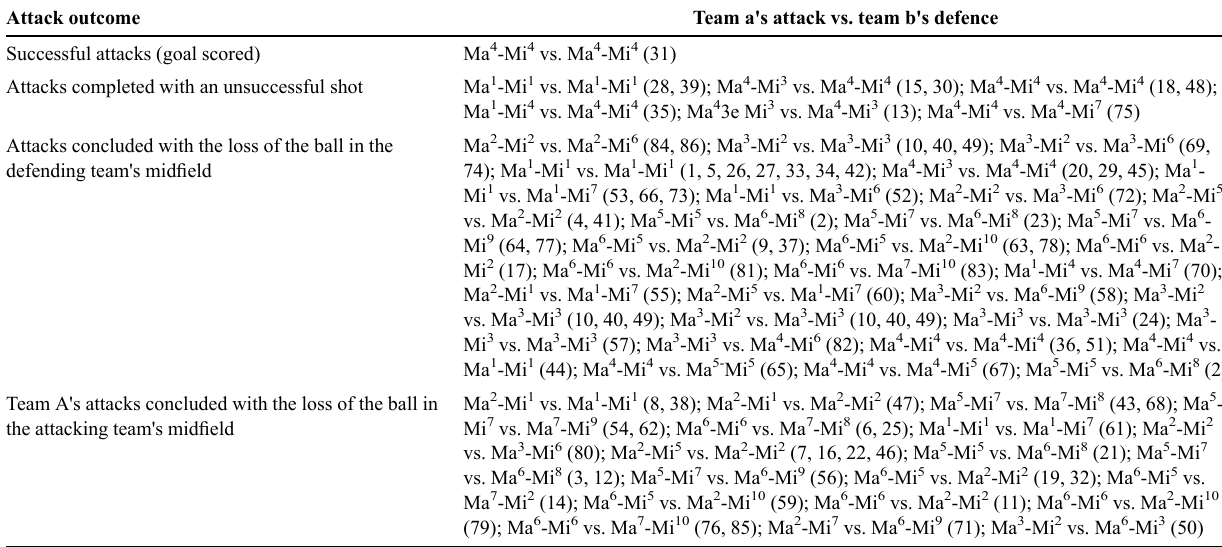
Table 2 - Macro-microstructure patterns of match 2 (attacks team Aversus defences team B) and achieved the outcome. The numbers in parentheses refer to the game sequence. Attack outcome